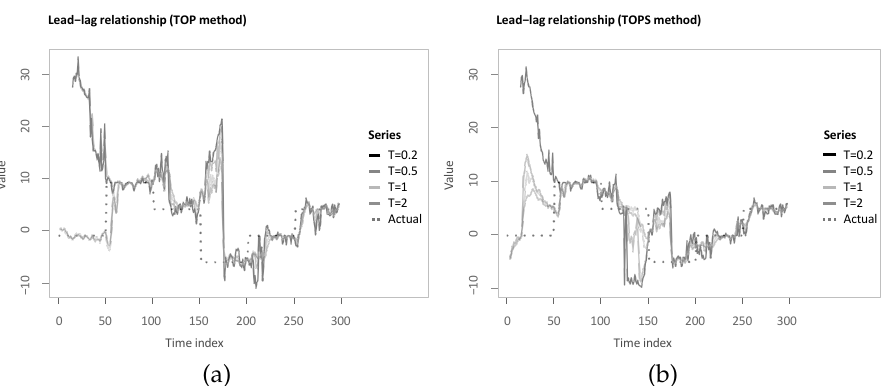
Figure 7. ( a ) Time-dependent lag structure estimate with the Thermal Optimal Path (TOP) method for different temperatures; ( b ) time-dependent lag structure estimate with the Symmetric Thermal Optimal Path (TOPS) method for different temperatures.